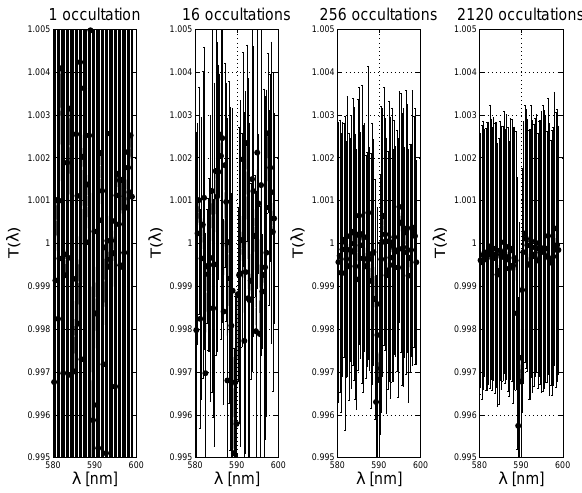
Fig. 1. GOMOS weighted median transmittance as a function of the number of occultations for the bin 70°N - 80°N in January 2005